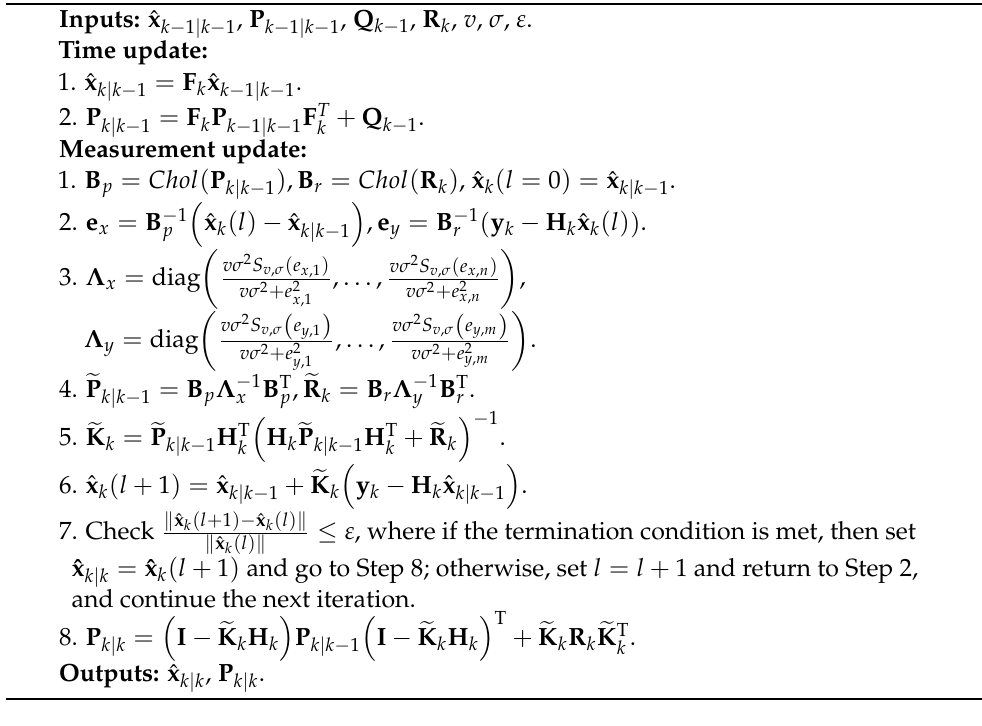
Algorithm 1: The implementation pseudocode for one time-step of the